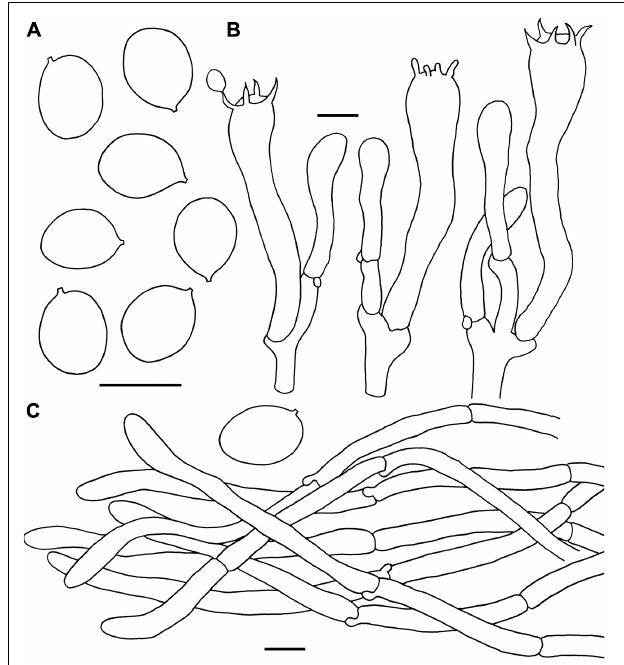
FIGURE 8 | Microscopic features of Craterellus minor (FHMU6554, holotype). (A) Basidiospores. (B) Basidia. (C) Pileipellis. Scale bars = 10 µ m. Drawings by Y.-Z.